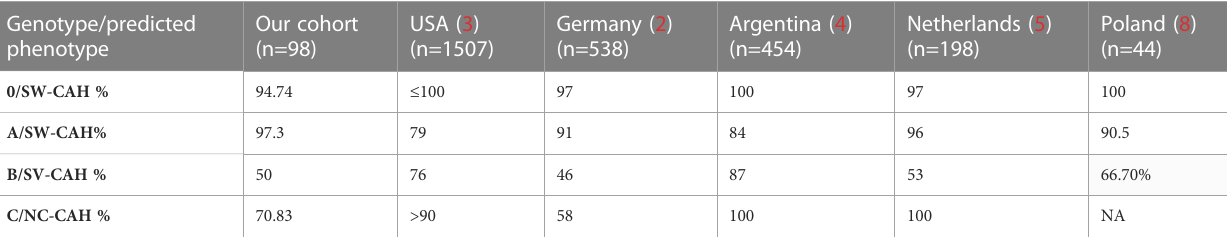
TABLE 4 Concordance of 0, A, B, C genotypes with assigned phenotypes compared to other studies.